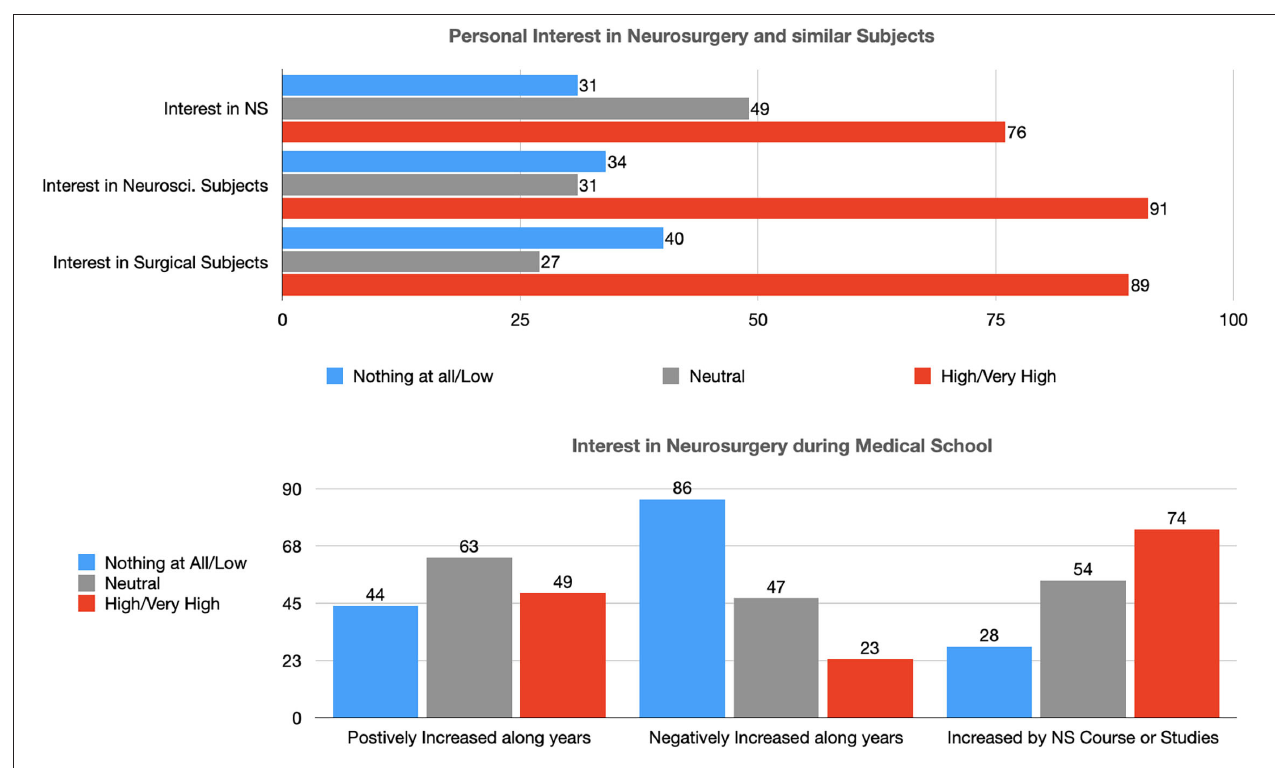
FIGURE 1 | Personal interest in neurosurgery and similar subjects (NS, Neurosurgery; Neurosci.,